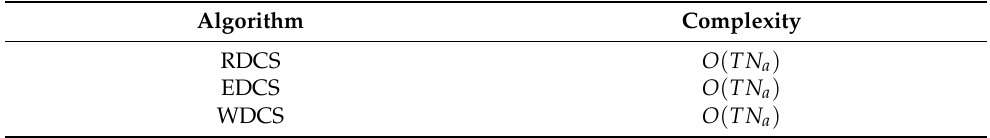
Table 4. Complexity comparison of dataset combination